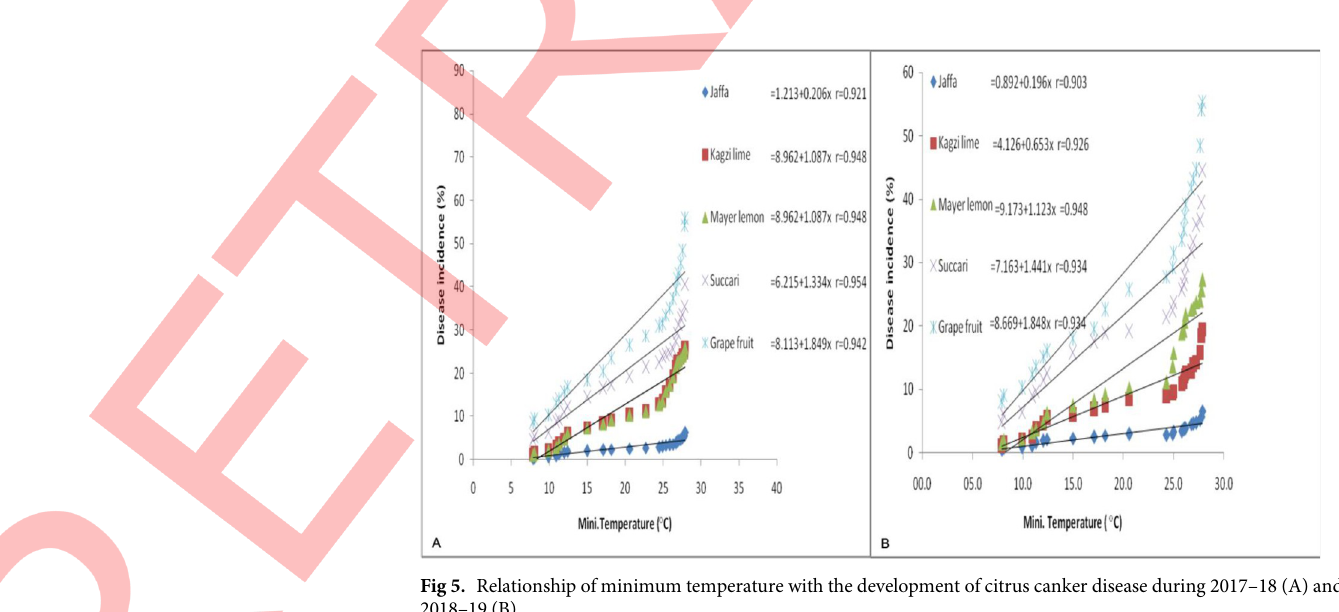
Fig 5. Relationship of minimum temperature with the development of citrus canker disease during 2017–18 (A) and 2018–19